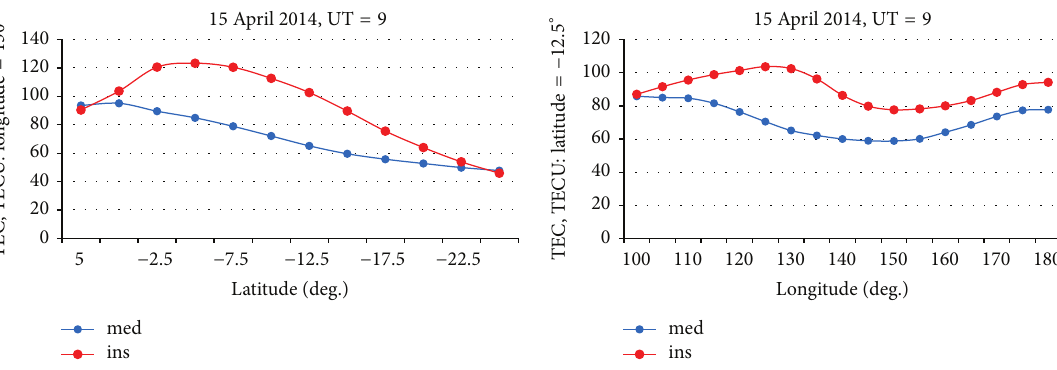
Figure 7: Latitude-longitudinal localization of increased ionization area.